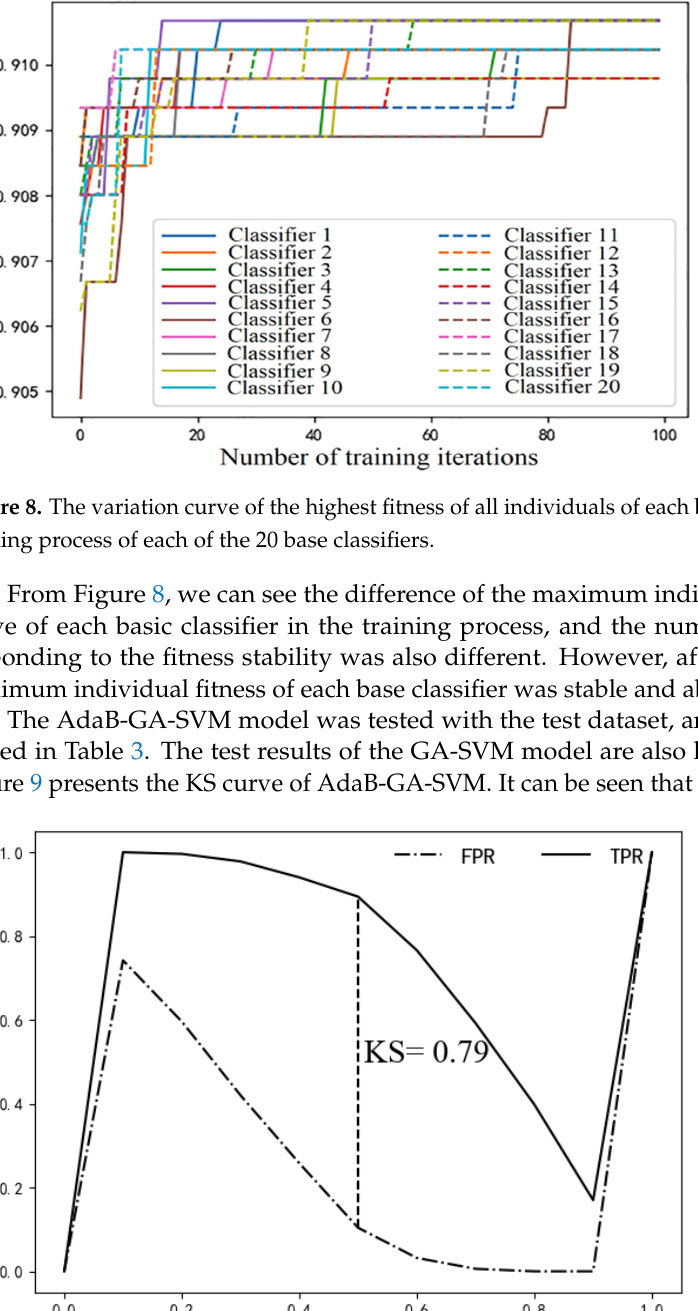
Figure 7. The variation curve of the coal gangue image recognition accuracy of AdaB-GA-SVM with a different number of integrated base classifiers.